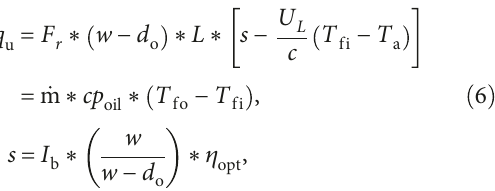
Table 2: Useful thermal power (kW) for a collector at the design